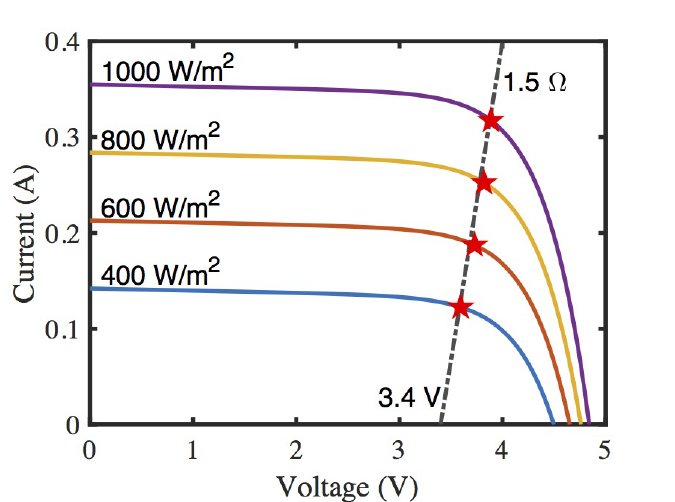
Figure 8. Optimal voltage-offset resistive control (VRC) values for a PV module at different irradiance values.